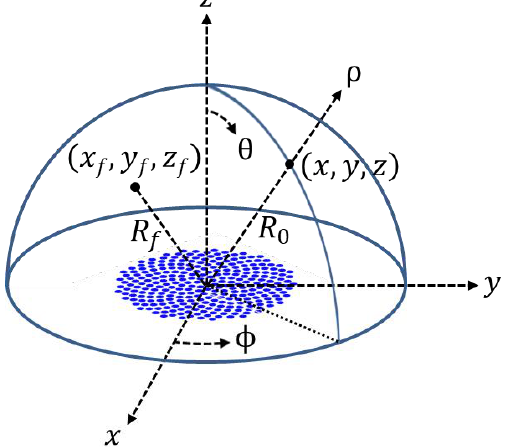
Figure 3. Coordinate system for the theoretical analysis and the beam